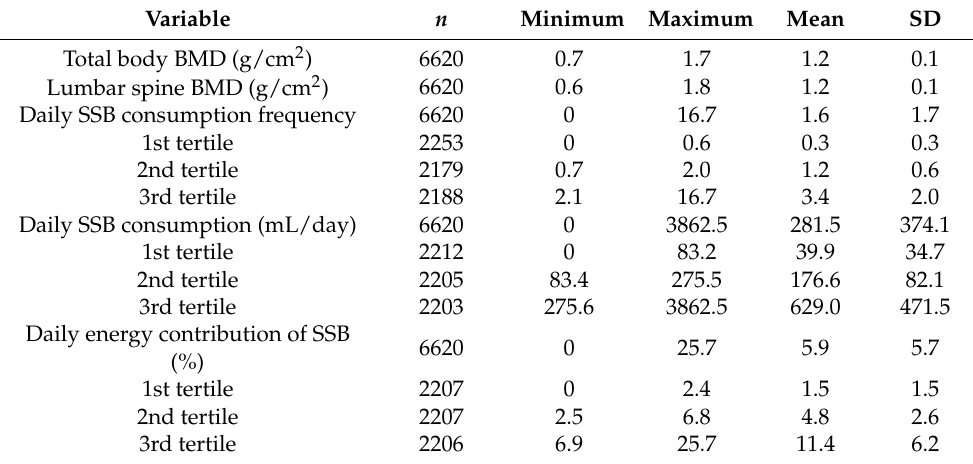
Table 2. Mean and standard deviation of bone mineral density and consumption of sugar-sweetened beverages by young people of the RPS Brazilian Birth Cohorts Consortium (Ribeir ã o Preto, Pelotas, and S ã o Lu í s). Ribeir ã o Preto 2016/2017, Pelotas 2015/2016, and S ã o Lu í s 2016.